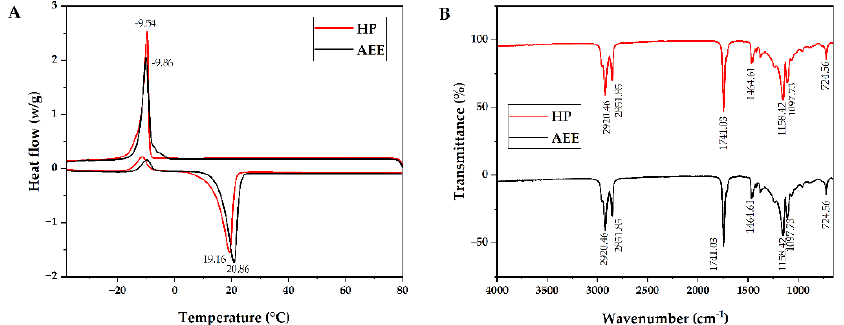
Figure 2. DSC curve ( A ) and FTIR spectrum ( B ) of CCSKO.